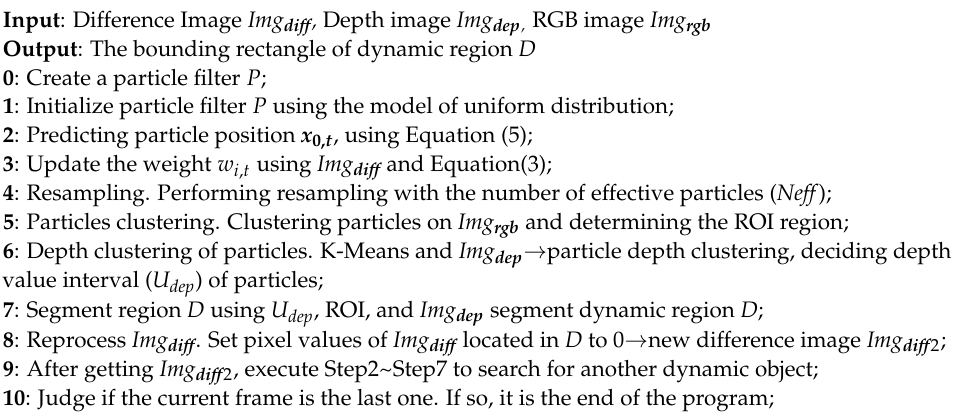
Algorithm 2 : Dynamic segmentation based on the depth image and particle